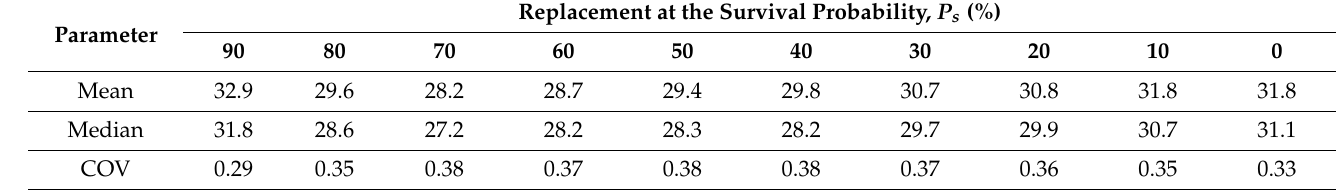
Table 3. Summary of means, medians, and COVs of the C L / C r for the example based on the simulations.